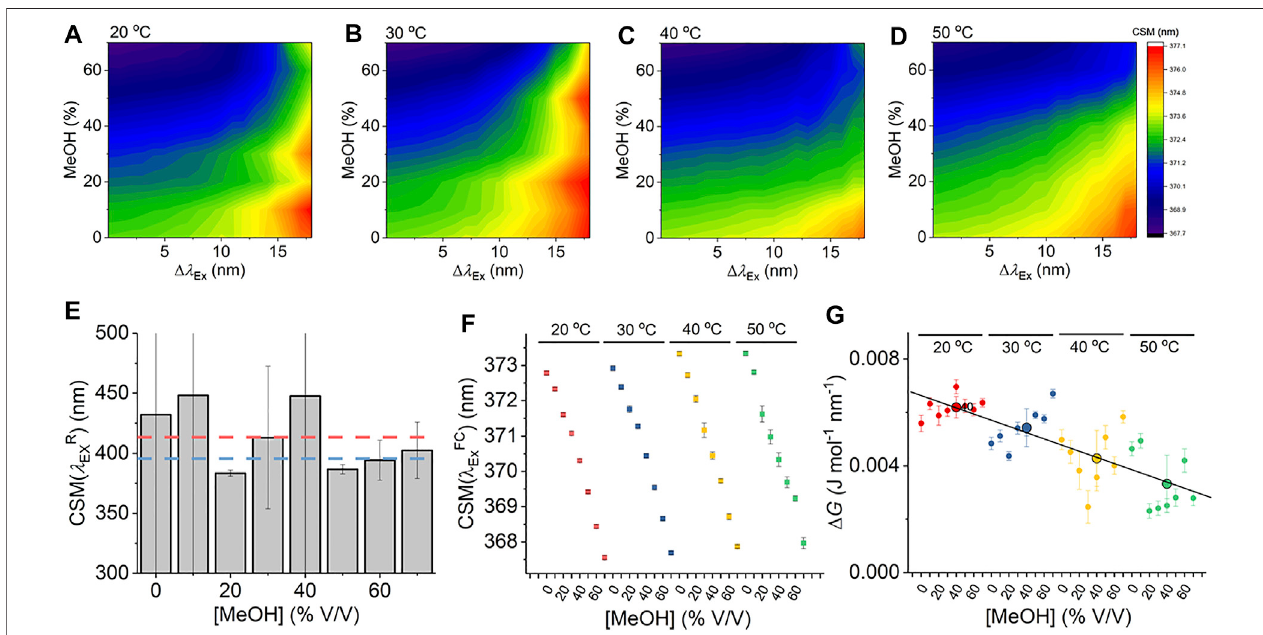
FIGURE2 | Solvent and temperature studies of the TrpREES effect. (A – D) Variation in CSM for L-Trp with varying percentages ofMeOHand versus temperature. (E) Variationinthe CSM ( λ R ex ) valueforeach[MeOH]studied,wherethe fi tted CSM ( λ R ex ) valueisasharedparameterforeachtemperatureatagiven[MeOH].Thedashed red line shows the average CSM ( λ R ex ) value, and the blue dashed line shows the CSM ( λ R ex ) value extracted where all data are fi t to Eq. (7) with CSM ( λ R ex ) as a shared parameter. (F) Variation in the CSM ( λ FC ex ) value for each condition studied. (G) Variation in the Δ G at fi xed λ Ex value for each condition studied. Large colored dots represent the average of [MeOH] at each temperature, and the error bars are the standard deviation. Conditions, 1 μ M L-Trp, 50 mM Tris – HCl, pH